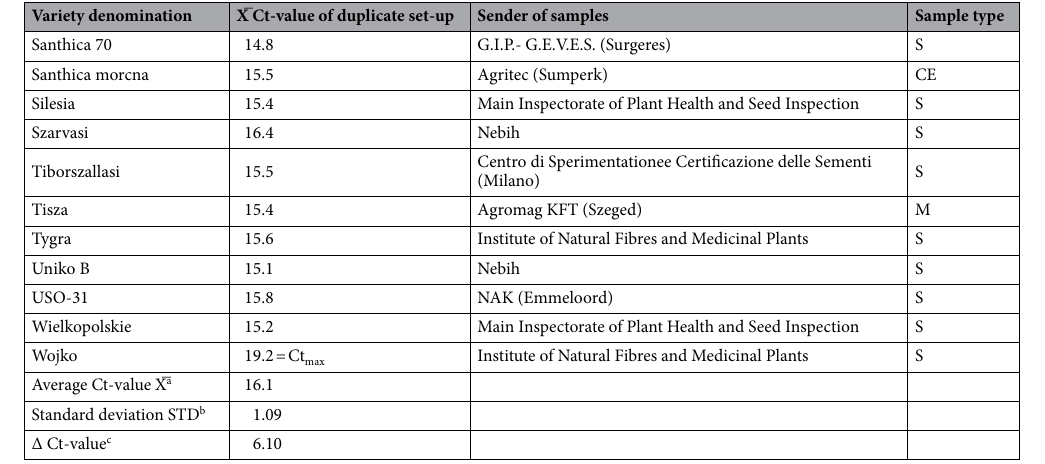
Table 1. Analysis of hemp varieties obtained with pool samples consisting of 5 seeds each. C: Consumer products/Commodities, for the purpose of further processing e.g. for feed production CE: Certified material in the approval process, which is not yet admitted M: Breeder cultivates the samples for the purpose of maintenance of the variety on behalf of the Owner S: Standard samples from national Community Plant